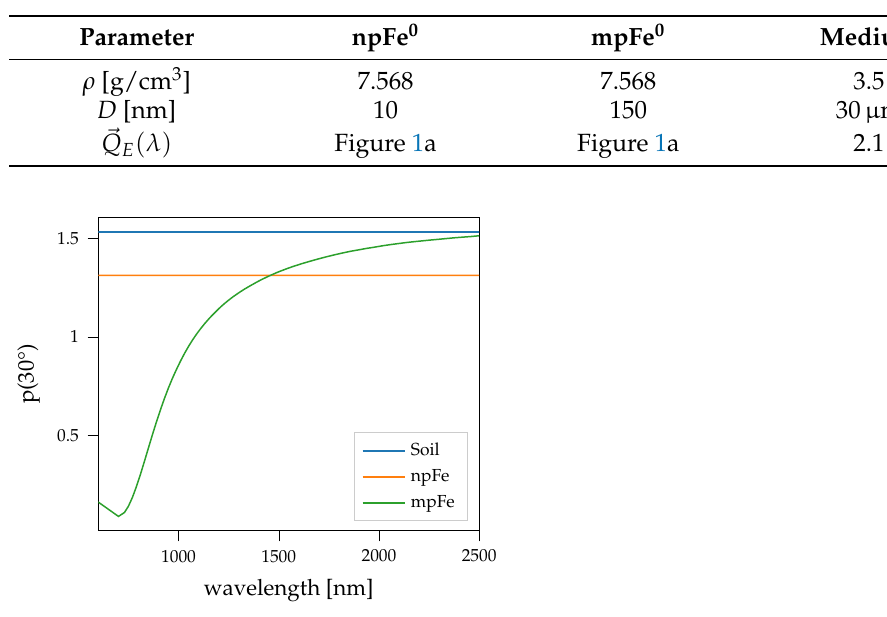
Figure 1. Extinction efficiencies and SSA spectra of the space weathering components npFe 0 and mpFe 0 calculated according to Wohlfarth et al. [24]. ( a ) Extinction efficiencies Q E ; ( b ) SSA. Table 1. Material parameters.